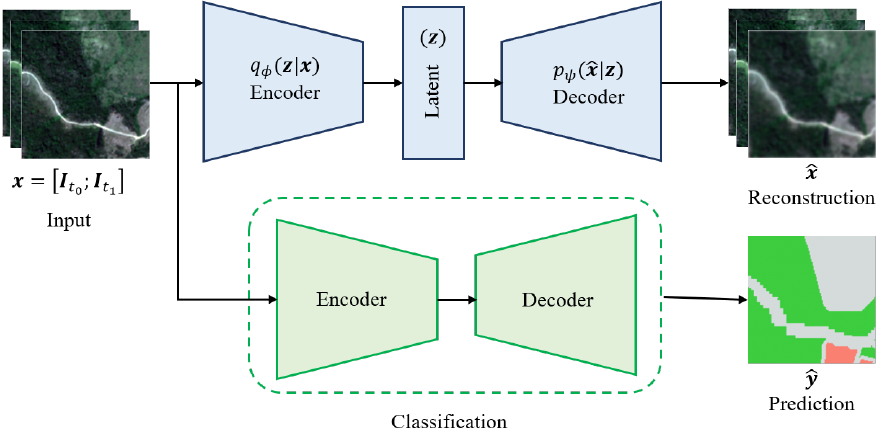
Figure 1. Fully Debiasing Variational Autoencoder (Fully DB-VAE) for semantic segmentation.